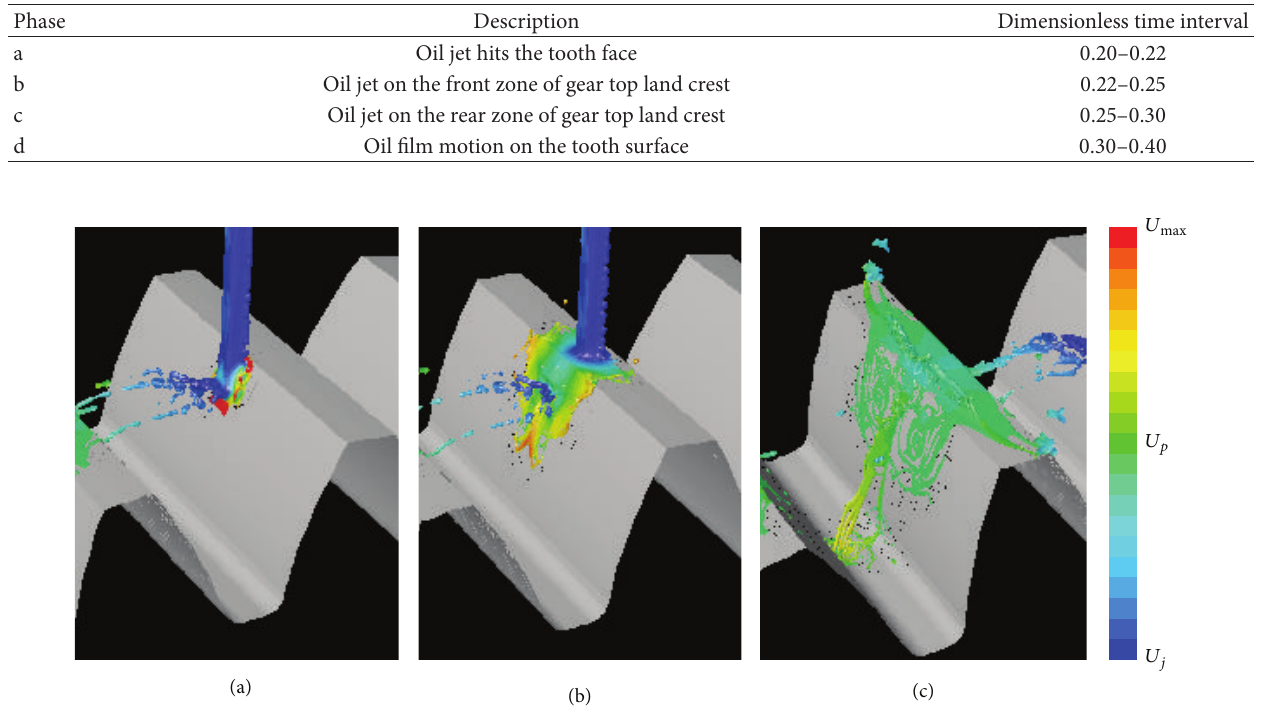
Table 5: Liquid-gear interaction phases.